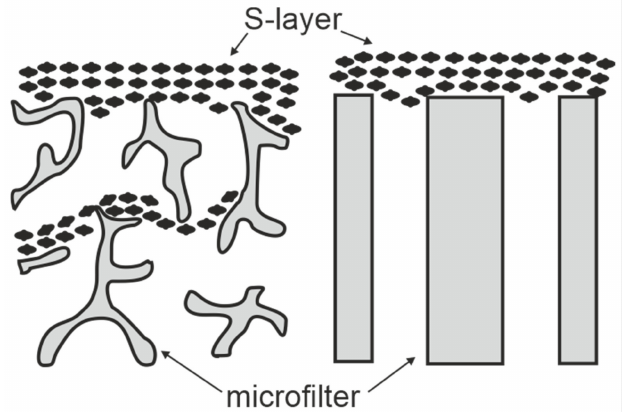
Figure 3. Schematic drawing of S-layer ultrafiltration membranes. Left: S-layer fragments are deposited on the surface and in the substructure of open-celled foam-like microfiltration membranes. Right: S-layer fragments are attached to the surface of radiation-track membranes. (Adapted from [8]. Copyright © 1986 with permission from Springer-Verlag).